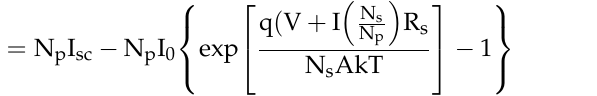
Table 2. Data of transformer of test